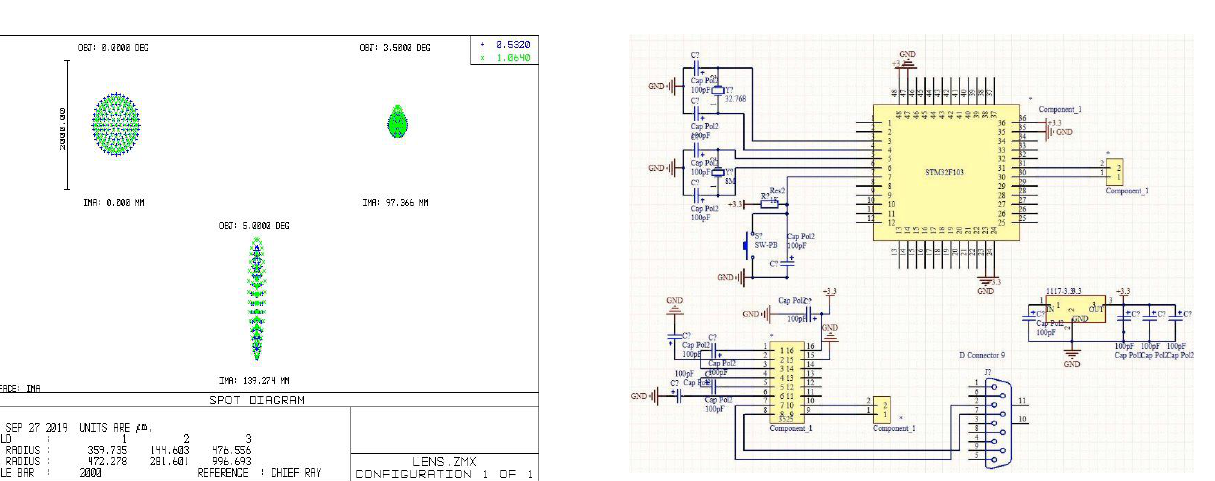
Figure 8. IMA Diagram of Compensation Lens